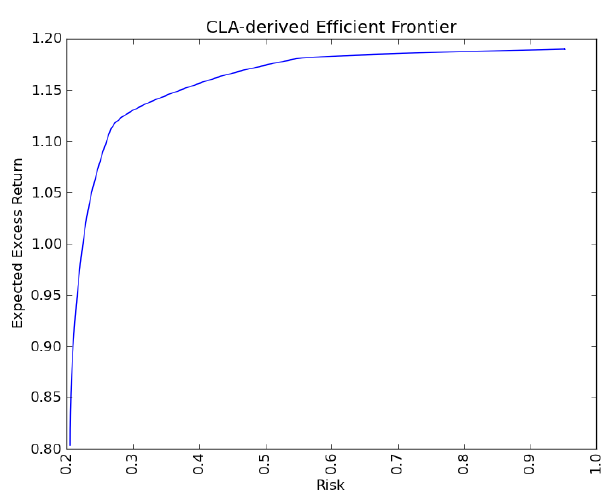
Figure 1. The Efficient Frontier